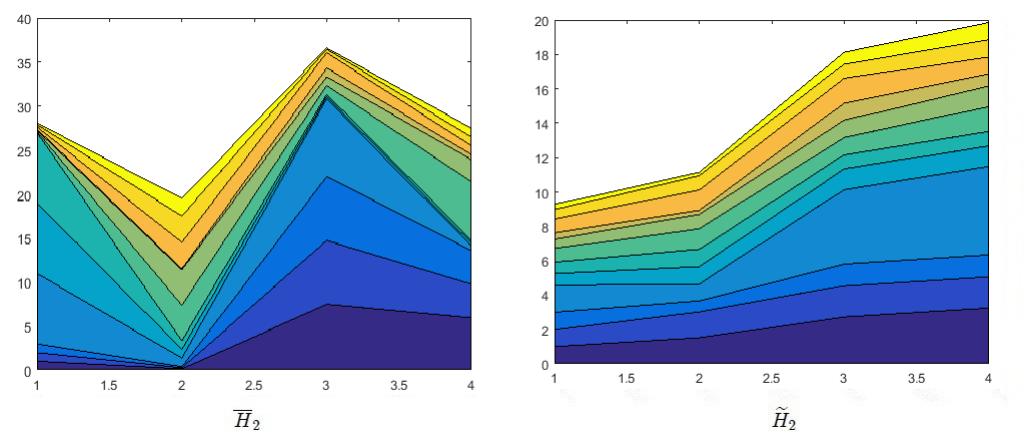
Figure 4. Area graphs of multiplicative preference degrees for H 2 .